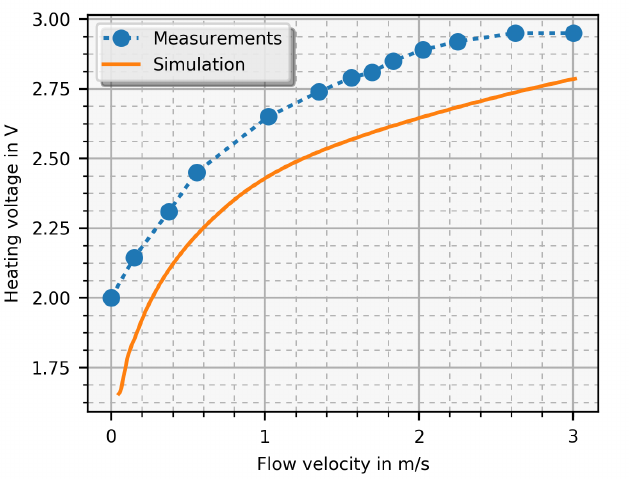
Figure 13. Simulated and measured heater voltage depending on the flow velocity in constant temperature mode where the temperature difference was set to